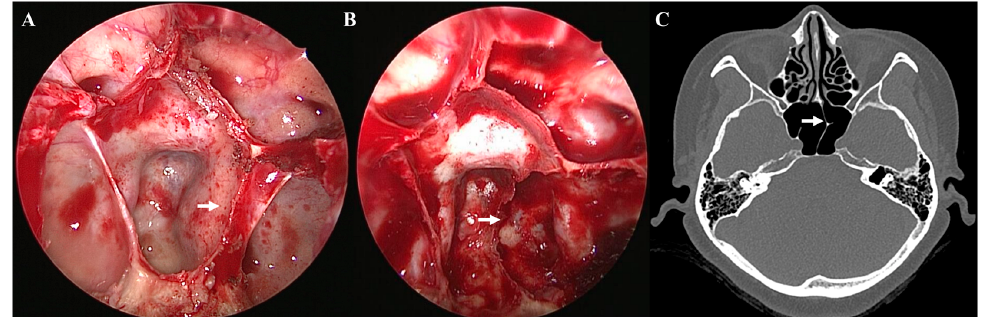
Figure 1. Complete pseudoclivus blocking clivus and left carotid artery. Endoscopic view ( A ) before removal of a left complete pseudoclivus (arrow) blocking clivus and left internal carotid artery ( B ) after the removal of a left complete pseudoclivus with exposed left internal carotid artery. ( C ) Non- enhanced preoperative paranasal sinus computed tomography scan of a patient presenting with a complete left pseudoclivus.